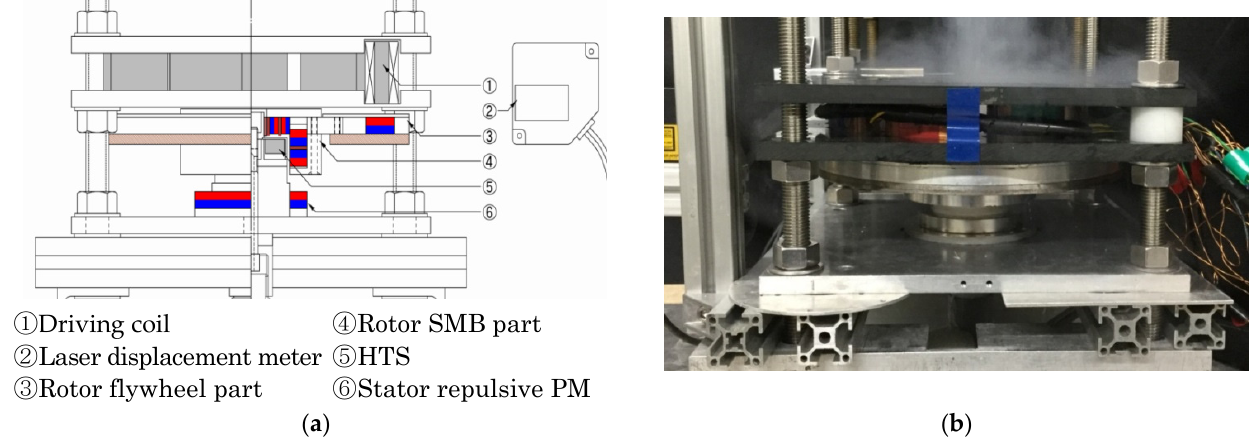
Figure 11. ( a ) Geometry and ( b ) Photogragh of experimental equipment.